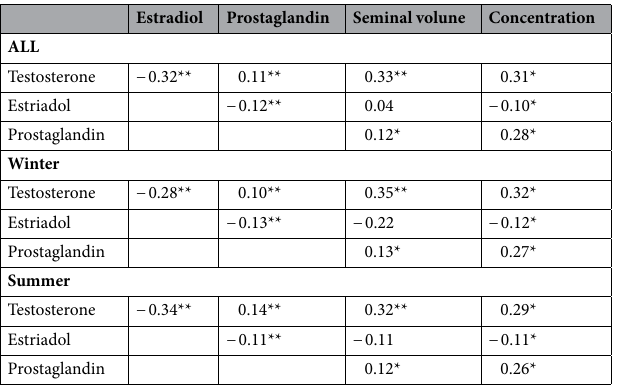
Table 10. Correlations of seminal hormone levels, semen volume and concentration, taking into account the semen collection season. Explanation: ** P ≤ 0.01; * P ≤ 0.05; ns = P > 0.05.